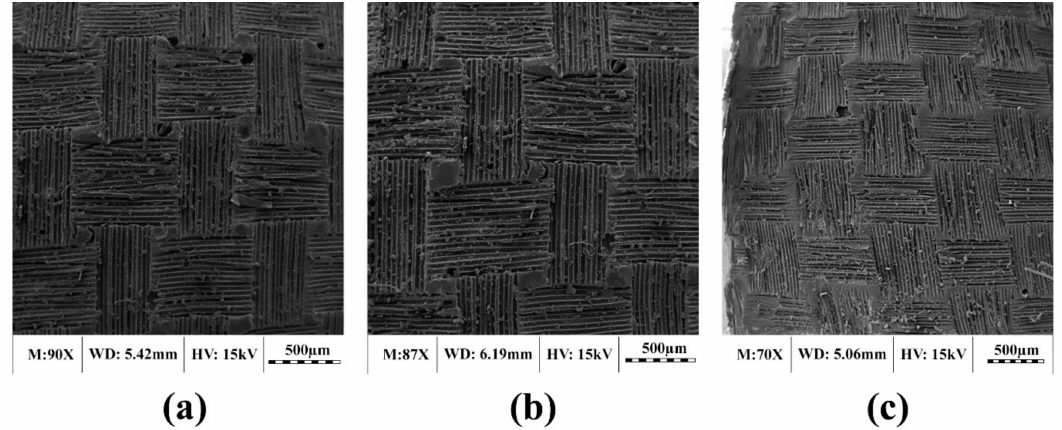
Figure 4. SEM micrographs of control laminates: ( a ) Unidirectional laminate (UL), ( b ) woven laminate (WL) and ( c ) chopped strand laminate